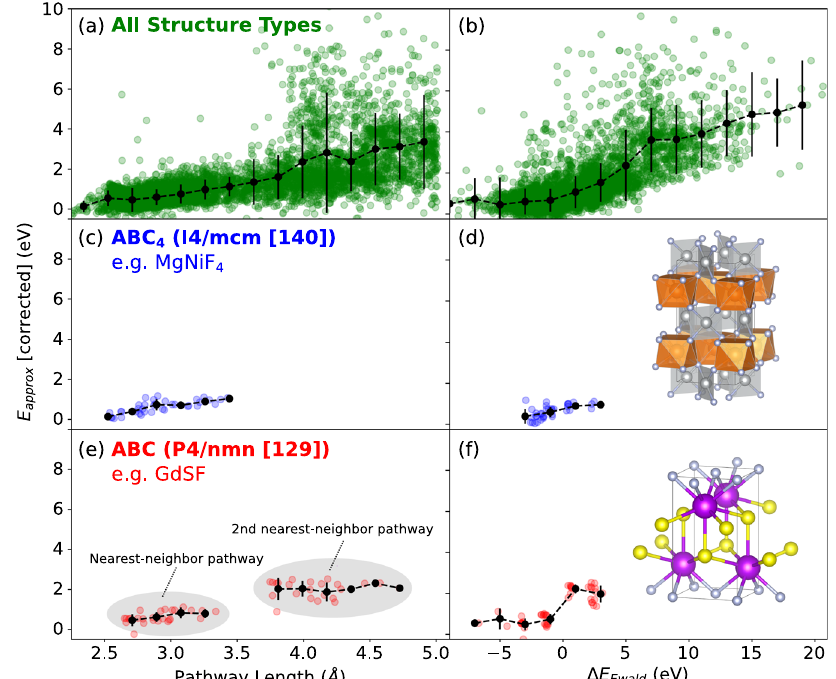
Fig. 4 Understanding fl uoride transport using pathway length (left column, a, c, e) and the change in Ewald energy ( Δ E Ewald ) (right column, b, d, f). Pathways for all structure types show moderate correlation with ( a ) pathway length and ( b ) Δ E Ewald . When pathways were analyzed structure type-by-structure type ( c – f ), we observed much tighter distributions for barrier heights. However, many structure types display barrier heights that are independent of these predictors (Supplementary Fig. 6). Trendlines and error bars for each subplot depict the mean and standard deviation of barrier heights within binned regions,